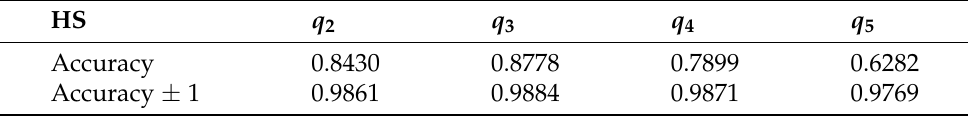
Table 4. Accuracy for prediction with HS.